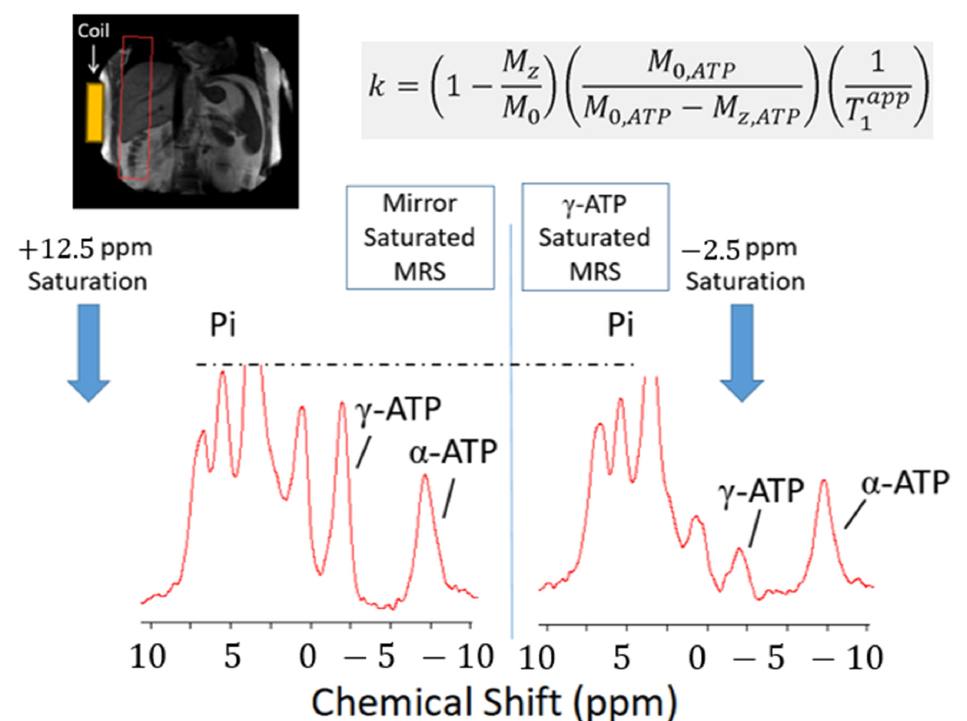
Figure 9. Saturation transfer technique in 31 P MRS. A frequency selective saturation pulse is applied to the gamma ATP peak in the phosphorus spectrum, with corresponding saturation . . . With this technique, ATP kinetics can be mathematically modelled utilising a first-order differential equation together with a rate constant, to calculate the forward rates of ATP synthesis in the